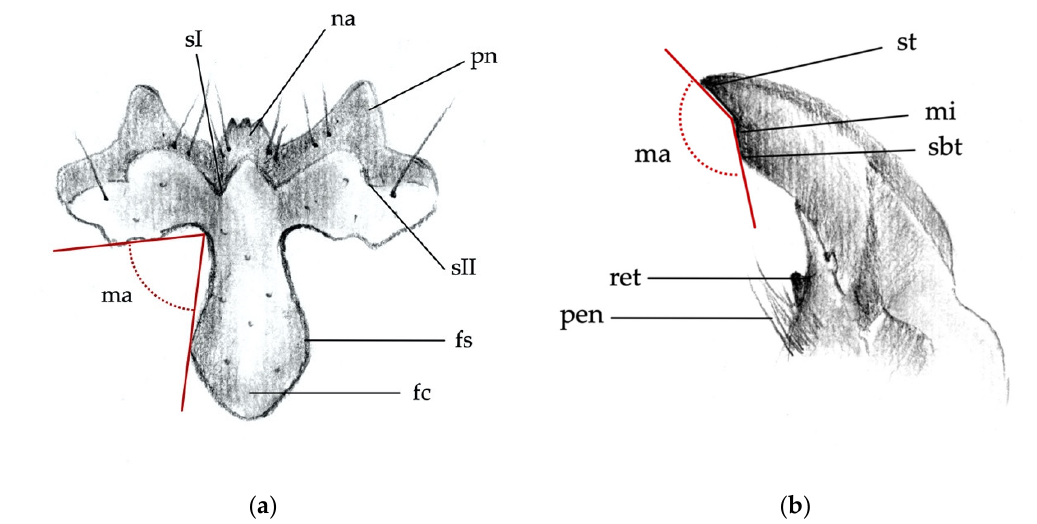
Figure 2. Main body parts distinguishing larvae of the different species. ( a ) Clypeus: fc, frontoclypeus; fs, frontal suture; ma, measured angle; na, nasal; sI, sII, sulci of the frontoclypeus; pn, paranasal lobe. ( b ) Right mandible: ma, measured angle; mi, inner margin of the apex; pen, penicillus; ret, retinaculum; st, apical tooth (apex of the mandible); sbt, subapical